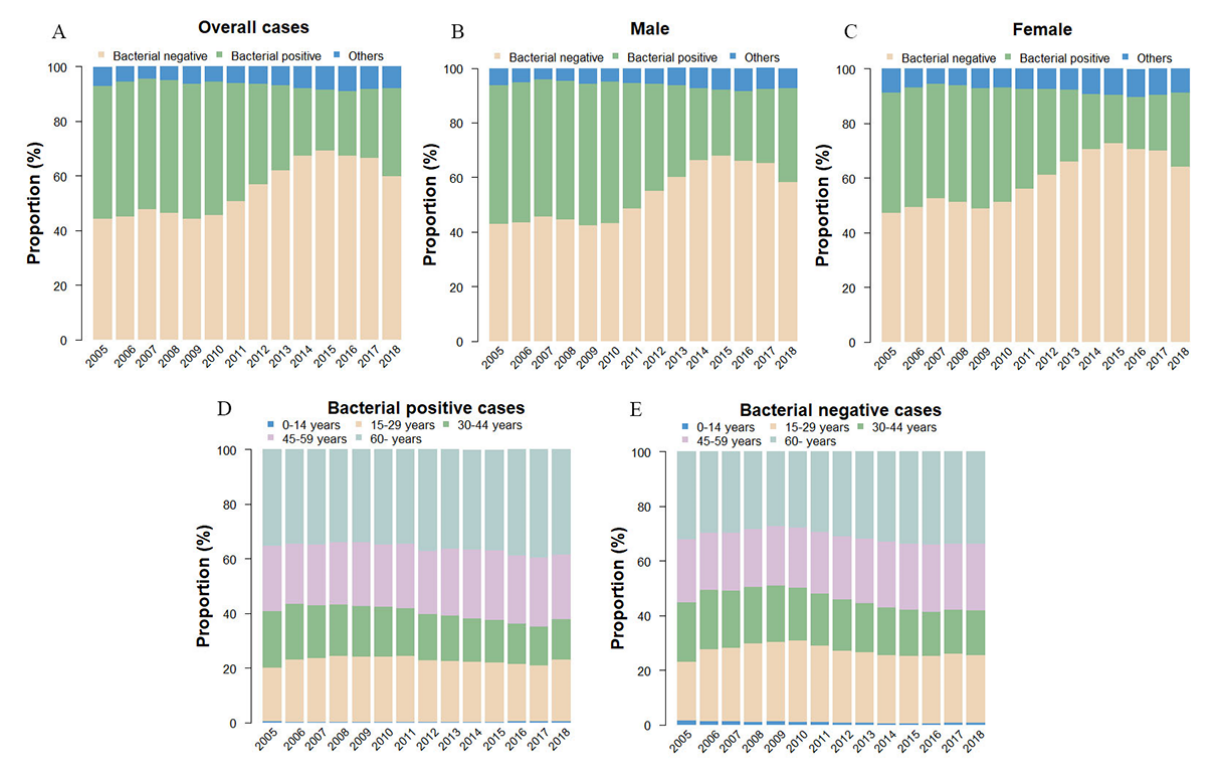
Figure 4. Proportion of laboratory-tested pulmonary tuberculosis (PTB) cases by sex and bacteriological type in Henan province, China, from 2005 to 2018. A: based on overall cases; B: based on male cases; C: based on female cases; D: based on bacteriological-positive cases; E: based on bacteriological-negative